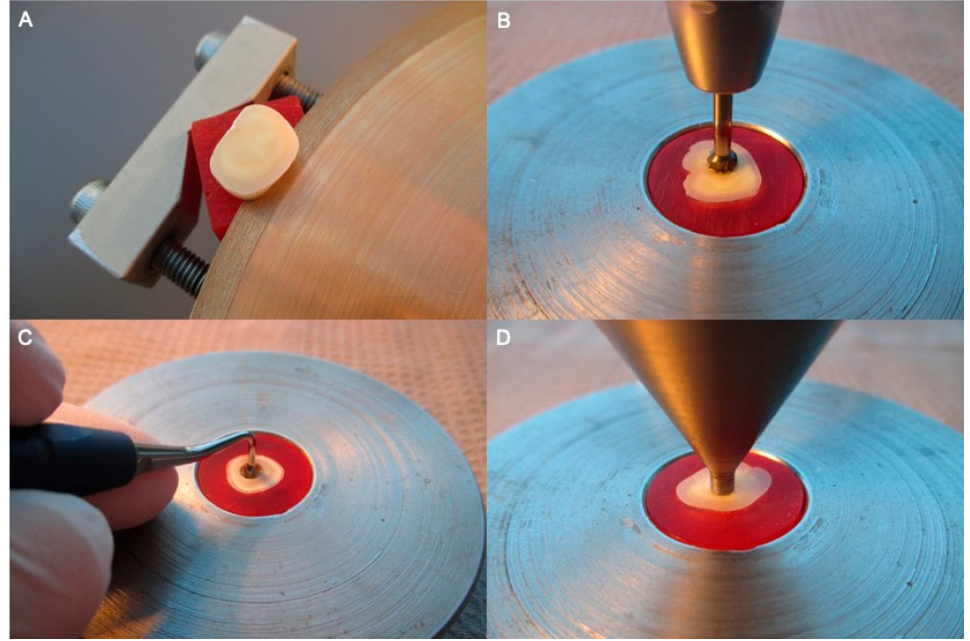
Figure 2. Specimens preparation: ( A ) Cutting process; ( B ) Drilling procedure; ( C ) Manual cavity filling; and ( D ) Push-out test procedure.